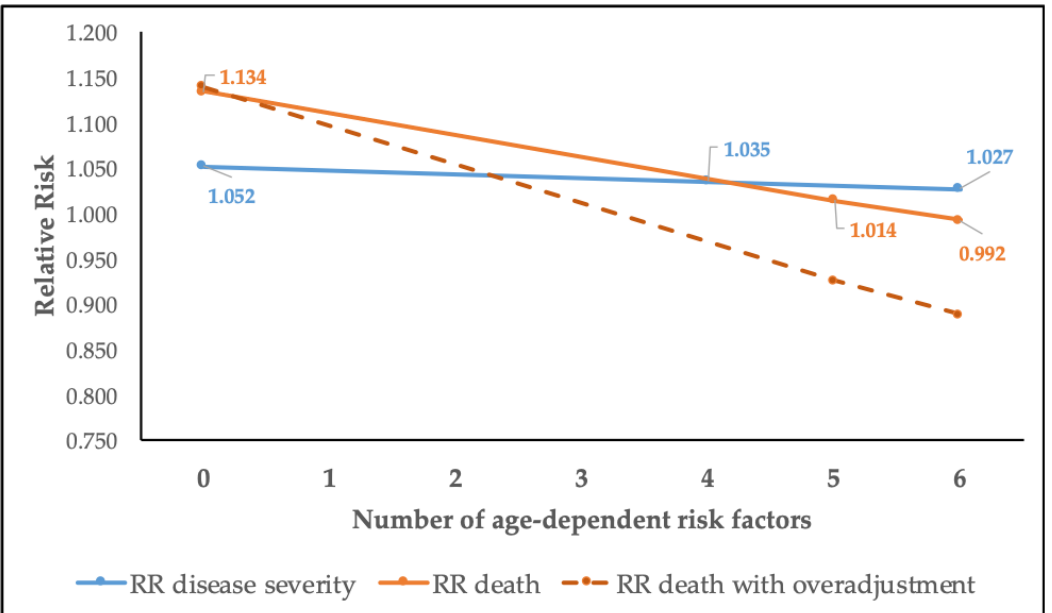
Figure 6. E ff ect of the adjustment scenarios on the relative risk (RR) of the association between age and COVID-19 disease severity and